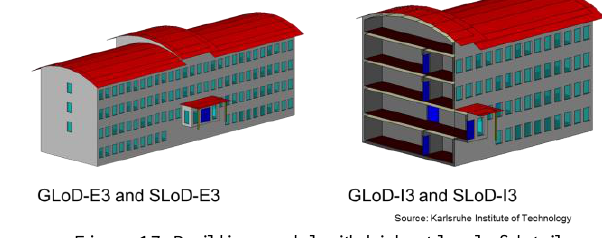
Figure 17: Building model with highest level of